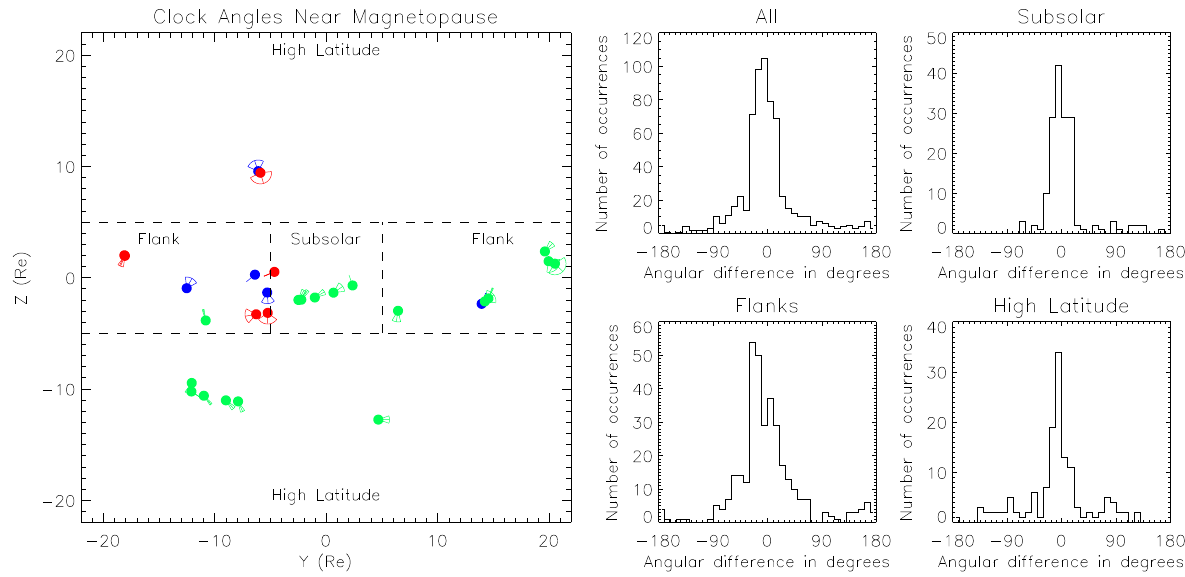
Fig. 9. Clock angles measured near magnetopause, and angular differences from perfect draping, for high solar wind dynamic pressure. Format as Fig. 2.